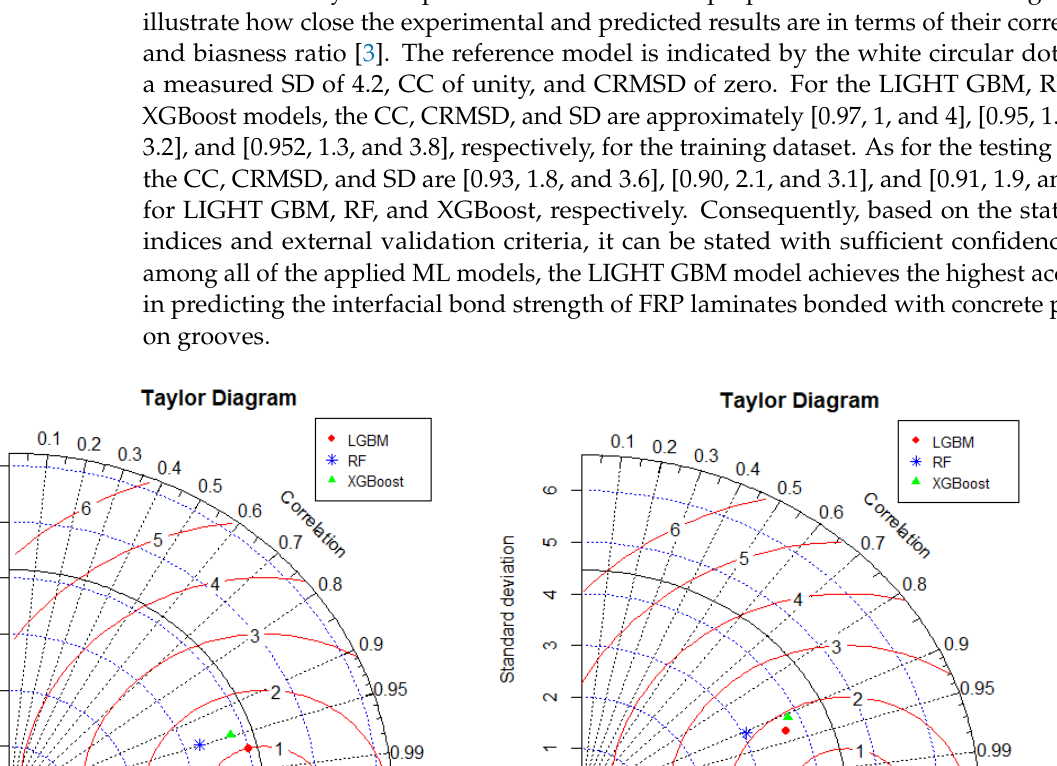
Figure 7. Feature importance of input variables using the SHAPASH library.